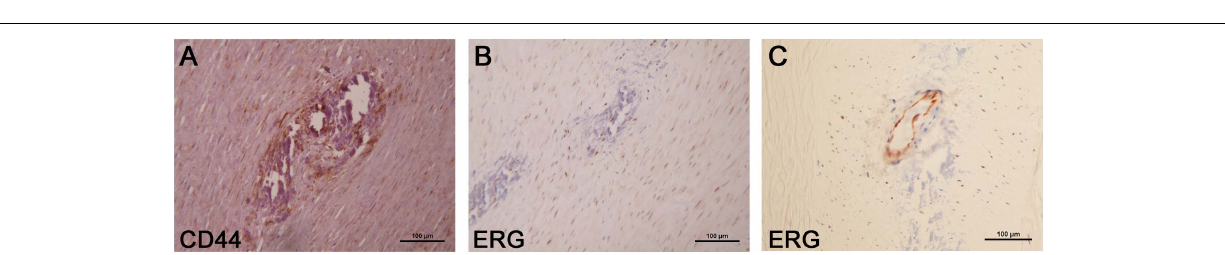
FIGURE 3 | Immunohistochemical analysis of the areas of calcification showed marked SLUG and SOX-9 positivity; in contrast, the endothelial cell lineage marker, FVIII, and the endothelial cell receptor, VEGF-R2, were negative. Scale bar for SLUG, SOX-9, and VEGF-R2 = 10 µ m; scale bar for FVIII = 100 µ m.